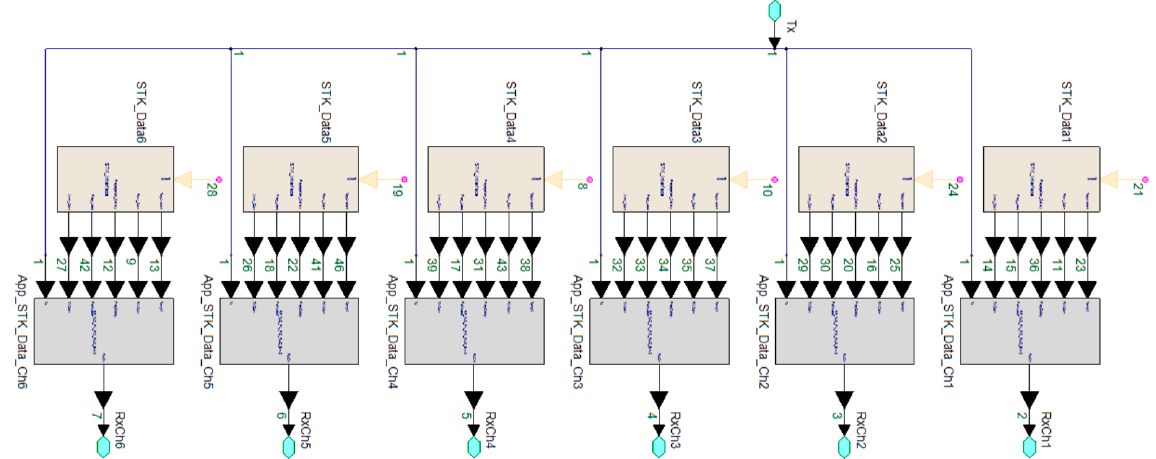
Figure A3. Six EM propagation channel models obtain data from STK to SVE and apply to TAR TX-signal.